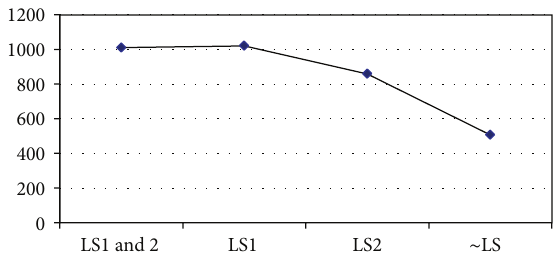
Figure 4: The effect of local searches on speed of